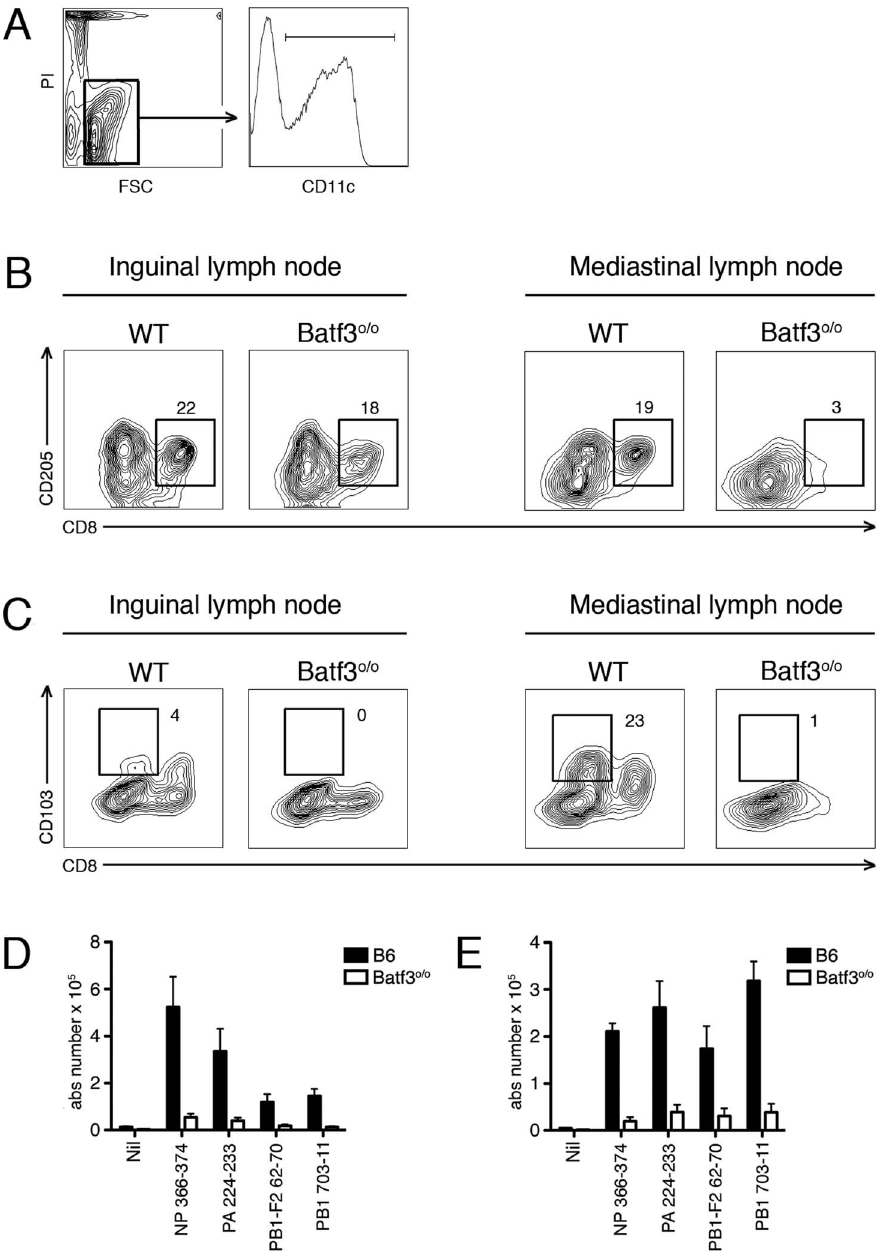
Figure 1. Lack of influenza specific T CD8 + responses in Batf3 o/o mice. (A) Pre-gating strategy to identify DC (B–C) DC from the inguinal and mediastinal lymph nodes of wildtype or Batf3 o/o mice on a B6 background were analyzed for their expression of either (B) CD8 and CD205 or (C) CD8 and CD103. Representative plots from 3-pooled mice from two independent experiments are shown. (D–E) B6 and Batf3 o/o mice were infected with PR8. On day 10, the absolute number of influenza specific T cells specific for defined peptide sequences were measured in the spleen (D) or BAL (E). The specific T cell response was elucidated following stimulation without peptides (Nil) or the peptides NP 366–374 , PA 224–233 , PB1-F2 62–70 , or PB1 703– + CD8 + T cells, calculated using the following equation: cell count x%PI 2 x%CD8 + x%IFN c + . Average is taken 711 . Shown is the absolute number of IFN c from between 5–6 mice per group over two independent experiments and the error shows the